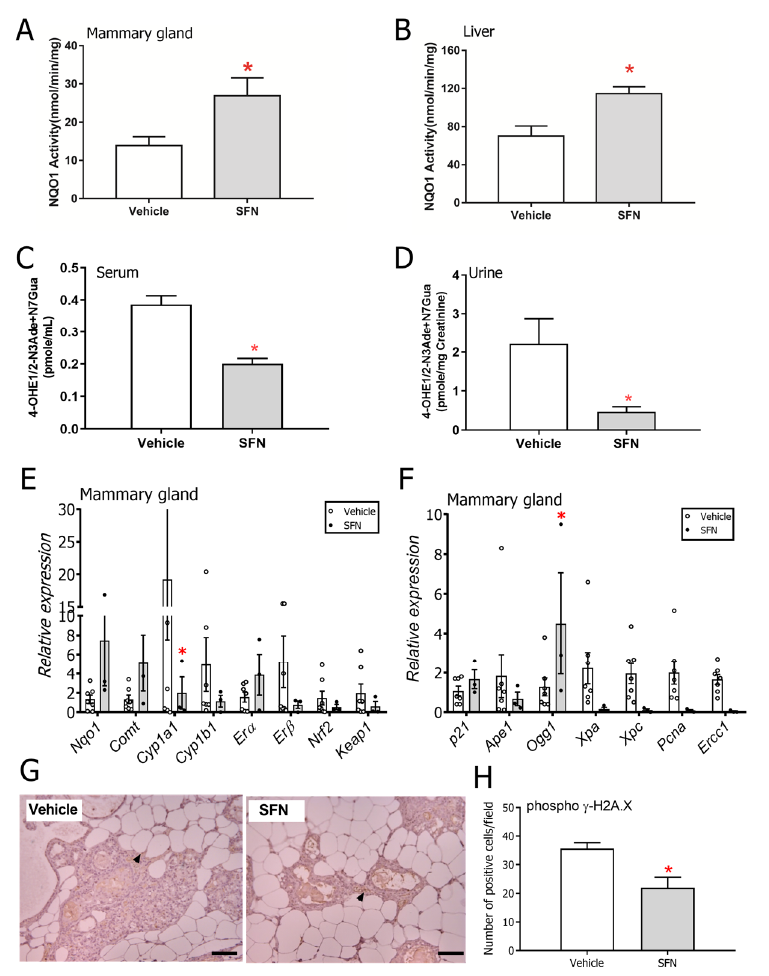
Figure 3. NQO1 activity level in ( A ) mammary gland and ( B ) livers of rats gavaged with vehicle (corn oil) or SFN after 7 weeks of 3 mg E2 implant. Depurinating estrogen-DNA adduct levels in ( C ) serum or ( D ) urine of rats gavaged with vehicle (corn oil) or SFN after 7 weeks of 3 mg E2 implant. ( E ) mRNA expression of NADP(H):quinone oxidoreductase ( Nqo1 ), Catechol-o-methyltransferase ( Comt ), Cytochrome P450 1A1 ( Cyp1a1 ), Cytochrome P450 1B1 ( Cyp1b1 ), Estrogen receptor alpha ( Er α ) , Estrogen receptor beta ( Er β ) , Nuclear factor erythroid 2–related factor 2 ( Nrf2 ), Kelch-like ECH-associated protein 1 ( Keap1 ) in the mammary glands of E2-exposed rats by treatment group. Gapdh was used as a housekeeping control and expression levels are relative to this. ( F ) mRNA expression of DNA damage repair and response-associated p21 , Ape1 , Ogg1 , Xpa , Xpc, Pcna and Ercc1 . Gapdh was used as a housekeeping control and expression levels are relative to this. ( G ) Phosphorylated γ -H2A.X immunohistochemistry and ( H ) quantification in the mammary glands of E2-exposed rats treated with either DMSO or SFN. Arrow heads depict representative positively stained cells. Magnification = 20x, Scale bar = 50 µ m. All samples used in this analysis were collected after the active DMSO / SFN gavage period and included both mammary tumor-bearing and non-bearing rats. Values are mean ± SEM ( n = 5 for activity and adduct analysis, n = 7 in DMSO group and n = 3 in SFN group for transcript analysis, n = 3 for immunohistochemistry). * p < 0.05 (Student’s t -test).